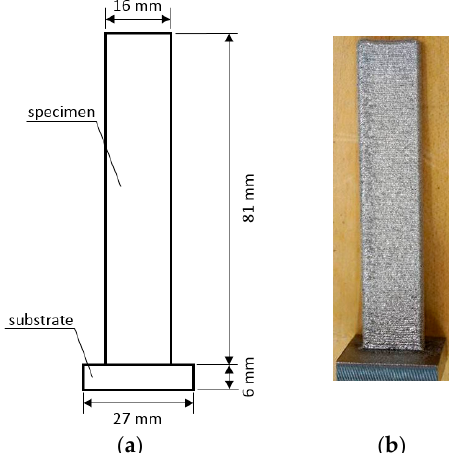
Figure 1. ( a ) Dimensional drawing of the as fabricated LENS specimen; ( b ) picture of LENS sample deposited on the substrate.